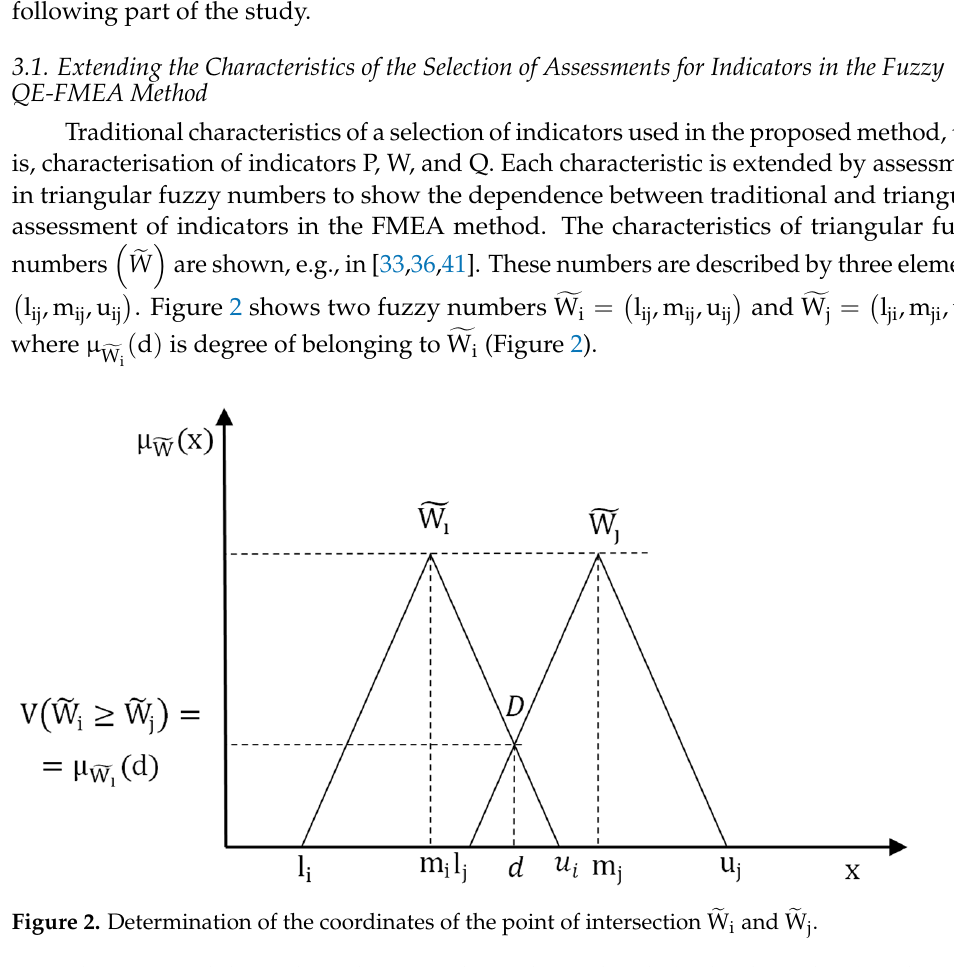
Table 1. Characteristic of assumed priority number P—probability occurring defect of process. Own study based on [27,31,42].